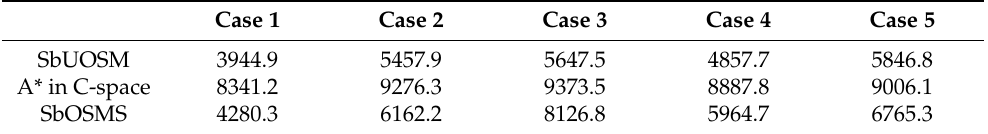
Table 3. Summary table of planning path deviations for the three algorithms under all six cases (Unit: mm).